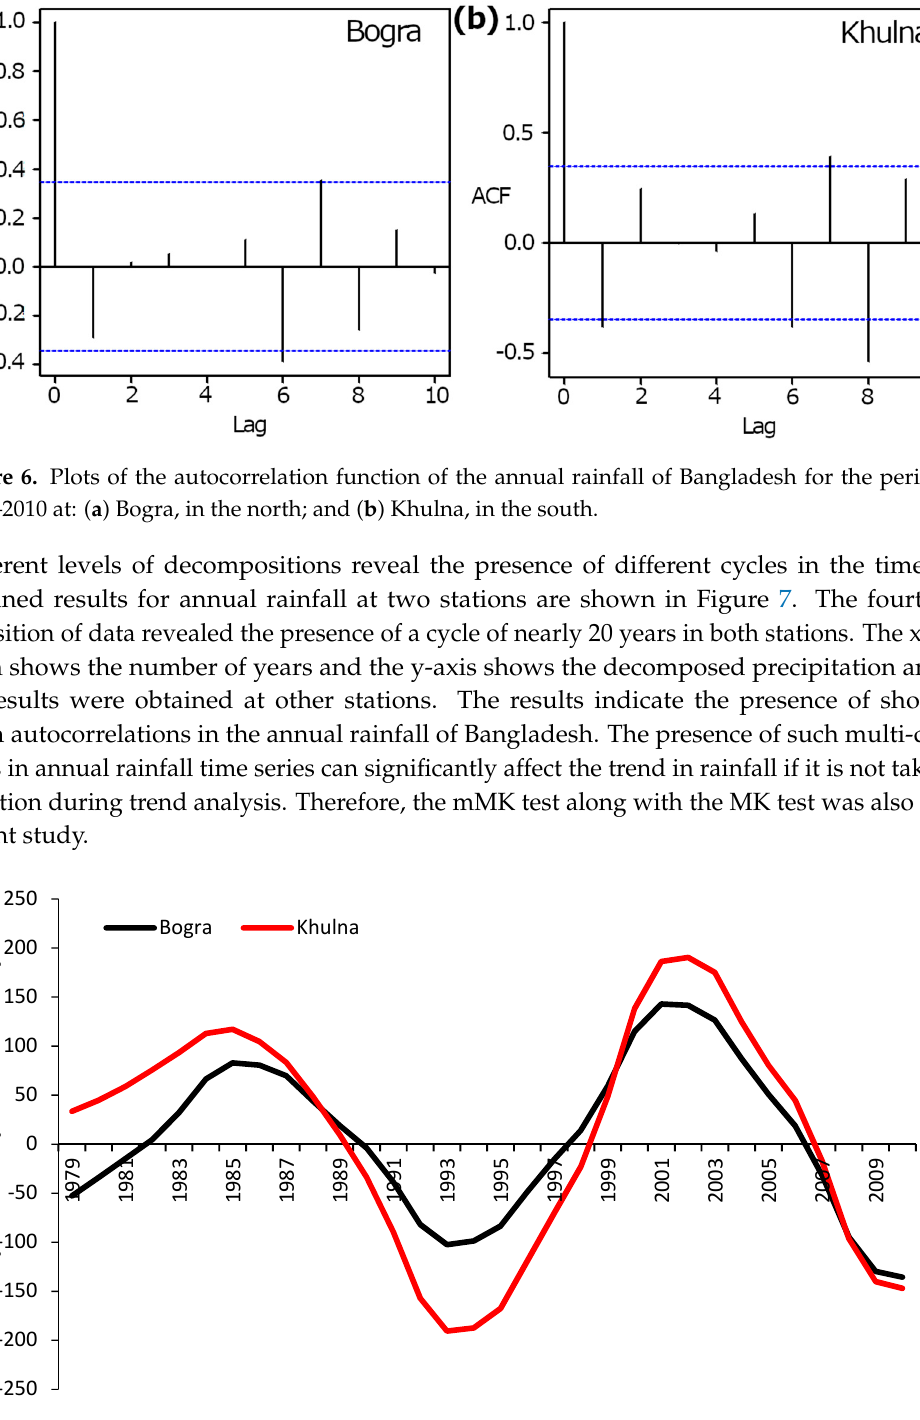
Figure 7. The fourth-level decomposition of the annual rainfall data for Bogra ( black ) and Khulna ( red ), which revealed the presence of multi-decadal variability with a cycle of nearly 20 years.